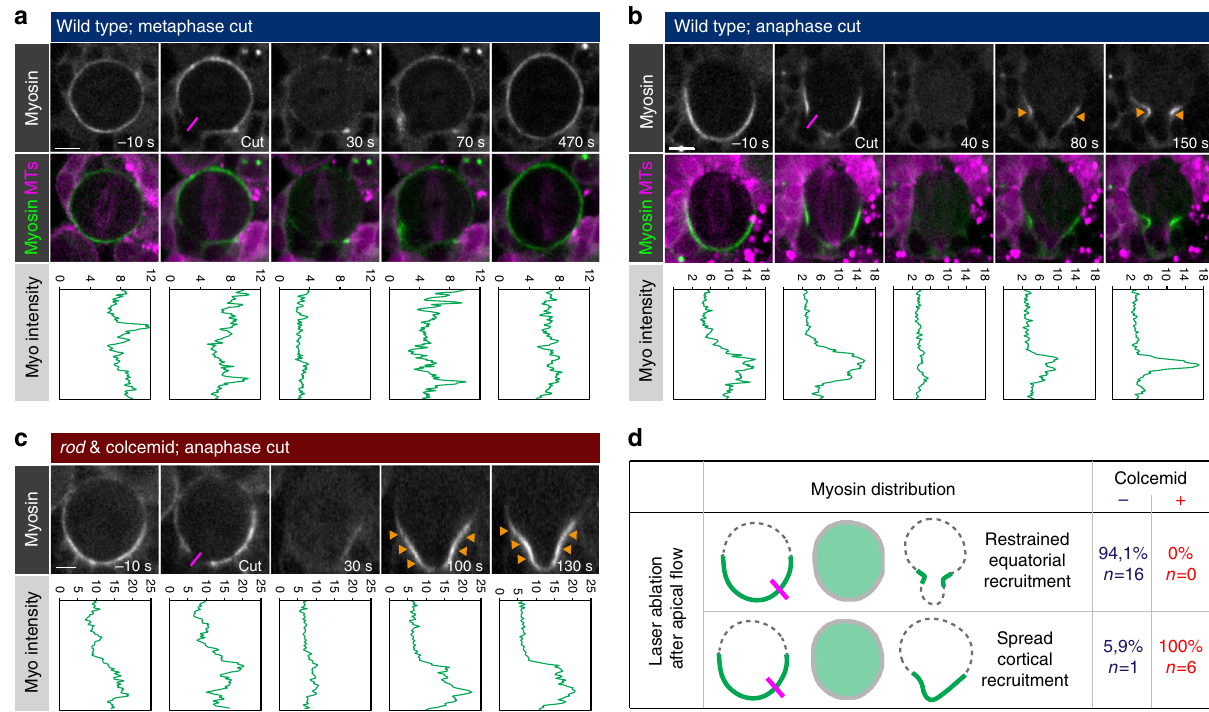
Fig. 6 The anaphase spindle is necessary for focusing Myosin localization at the cleavage furrow. a Laser-induced cortical cutting experiments performed on third instar wild-type neuroblasts expressing Sqh::GFP (Myosin, white; upper panel, green; lower panel) and Cherry::Jupiter (MTs; magenta) in metaphase, or b anaphase. For this and subsequent panels, the cortical cutting site is highlighted with purple lines. Orange arrowheads highlight Myosin recruitment. Myosin intensity pro fi les, measured from the apical to the basal cortex, are shown underneath the corresponding image. c Laser-induced cortical cutting experiments performed on third instar rod mutant neuroblasts exposed to colcemid in anaphase. Only Sqh::GFP (Myosin; white) is shown. d Experimental summary. Time is shown as seconds before and after cortical cutting. Scale bars: 5 µ